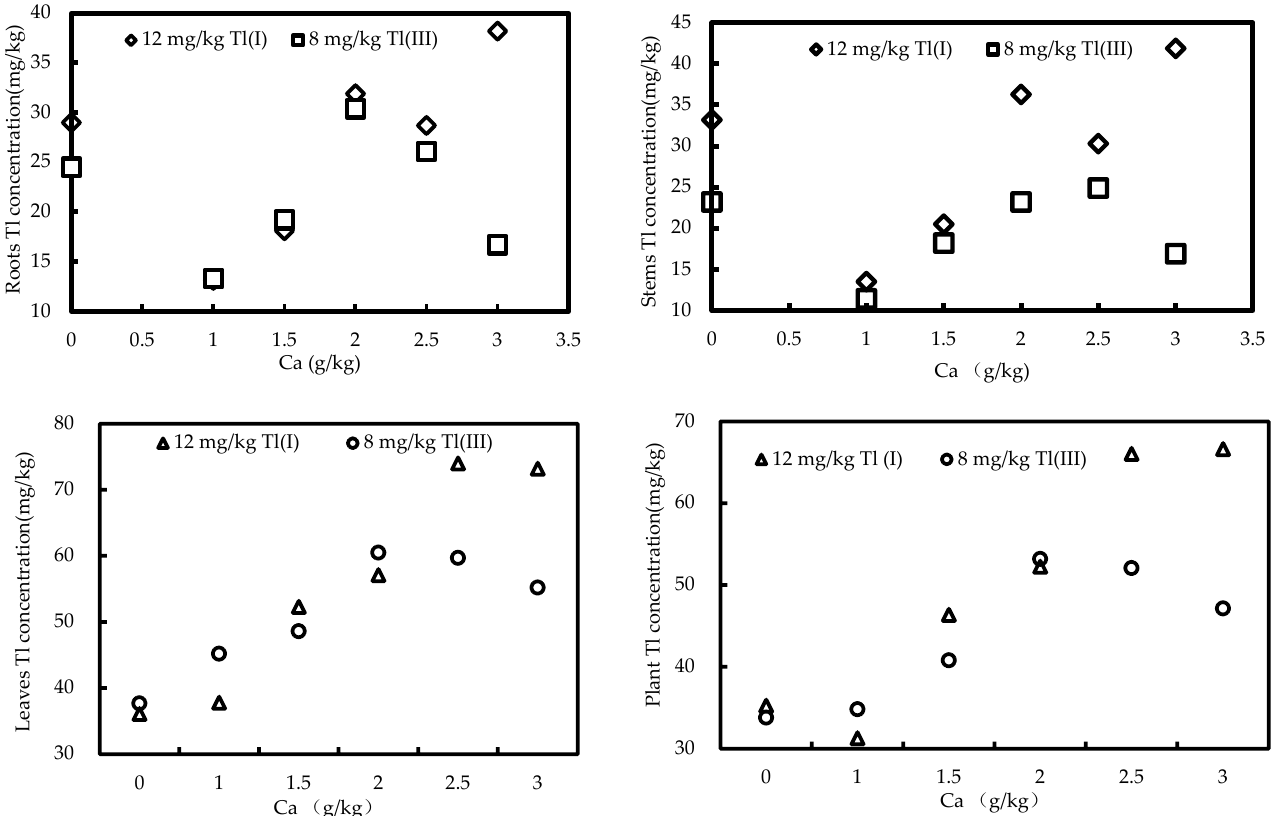
Figure 3. The relationship between the Tl in plants (roots, stems, leaves, whole plants) and the spiked Ca in pot soil.